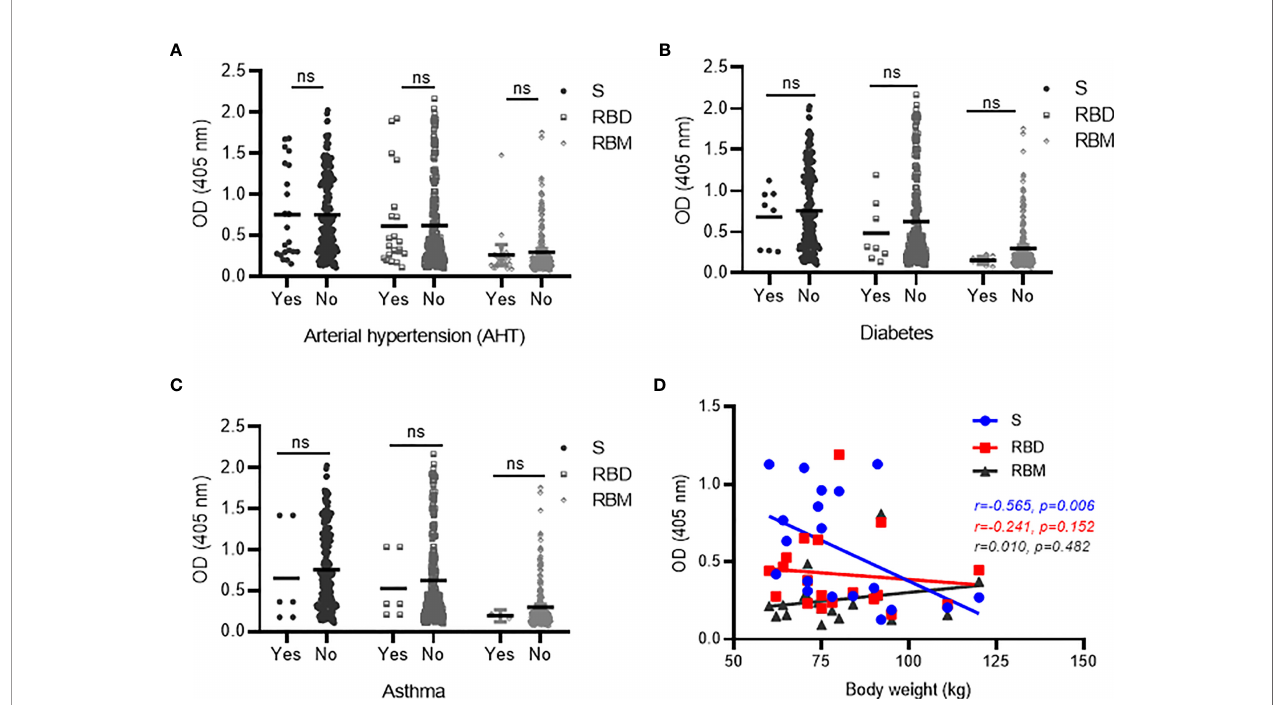
FIGURE 6 | Correlation between antibodies against S, receptor-binding domain (RBD), and receptor-binding motif (RBM) and comorbid conditions in COVID-19 patients. No signi fi cant variation was observed in antibody responses against S, RBD, or RBM between COVID-19 patients with the presence (Yes) vs. absence (No) of comorbid conditions, such as AHT (hypertension) (A) , diabetes (B) , and asthma (C) . However, a trend toward increased antibody levels for all three antigens was observed in the COVID-19 patient groups with no diabetes (B) or asthma (C) . (D) Spearman ’ s rank analysis shows a signi fi cant negative correlation between antibody levels for S and body weight but showed no signi fi cant impact on antibodies against RBD and RBM in COVID-19 patients. ns, not signi fi